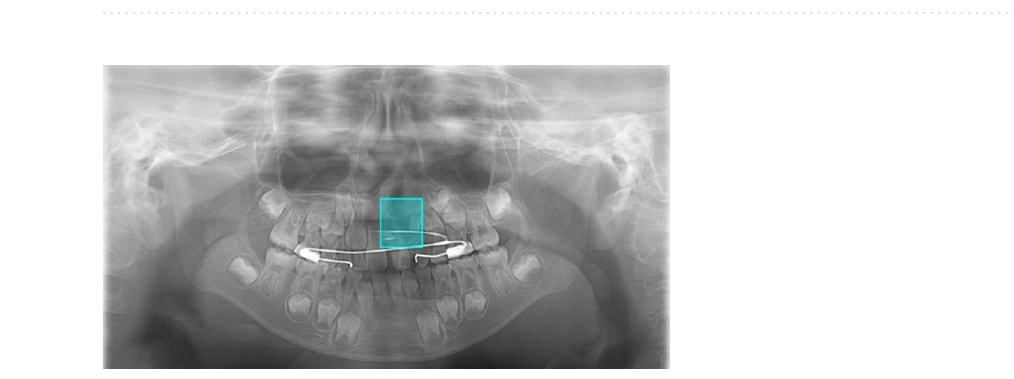
Figure 5. A correctly detected but erroneously classified case. On a panoramic image of a patient with solely CA (CA only group), the cleft area was correctly detected but is misclassified into the CA with CP group. The lateral incisor shows findings of microdontia with slight medial inclination, but the inferior piriform aperture line is obscure on the affected side, and the radiolucency of the cleft area is relatively